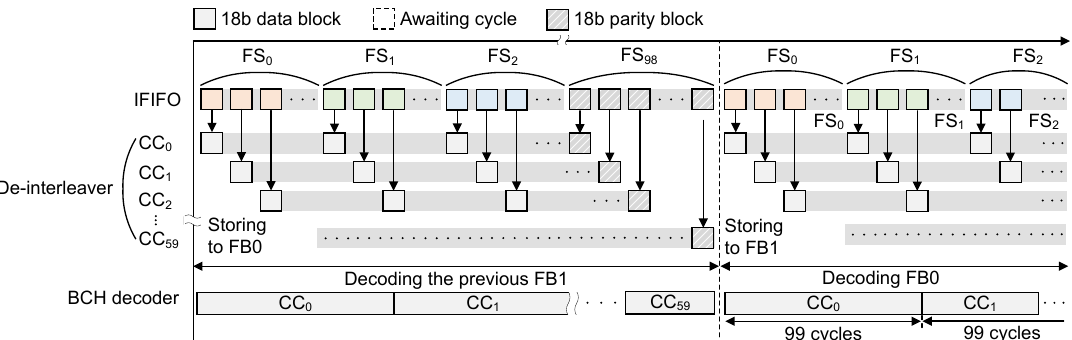
Figure 5. Proposed de-interleaving and buffering scheme for seamless error